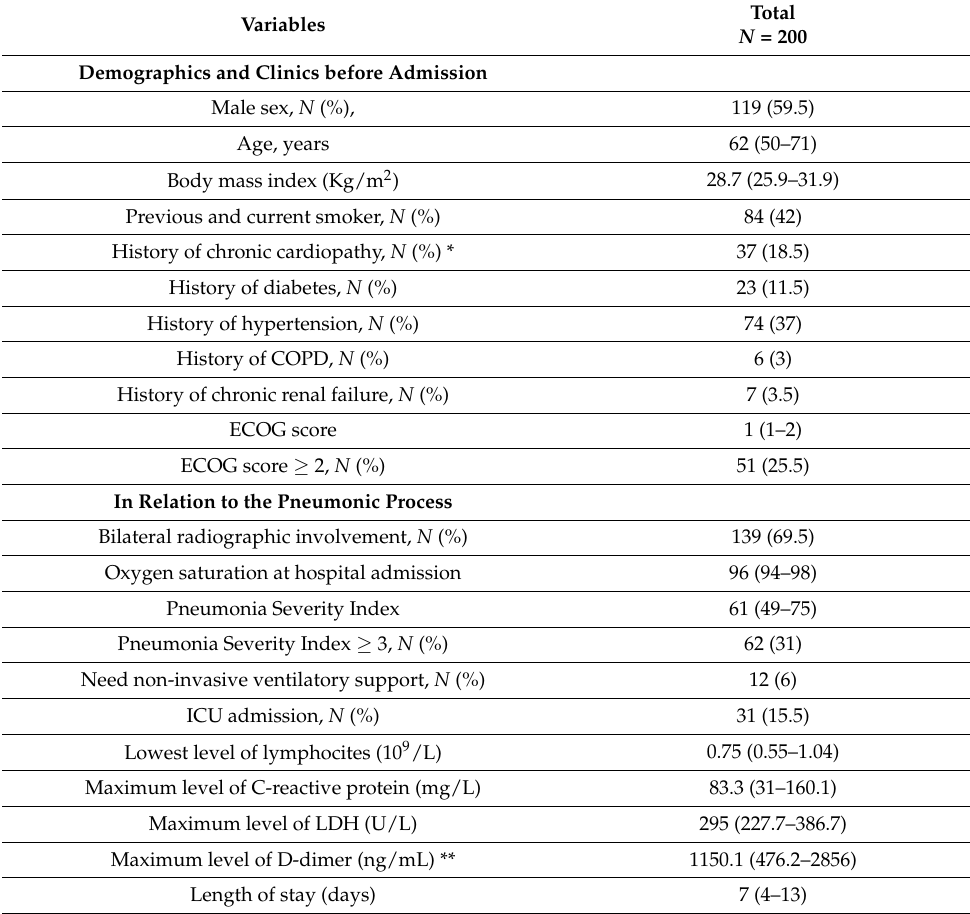
Table 1. Sociodemographic, clinical, and general characteristics of the pneumonic process caused by COVID-19 in the patients included in the